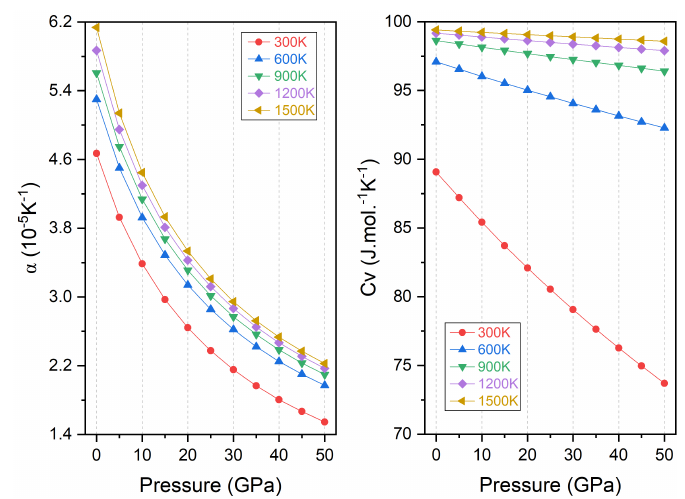
Figure 12. The thermal expansion coefficient ( α ) and heat capacity at constant volume (C V ) variation with pressure for Ti 2 MnAl.